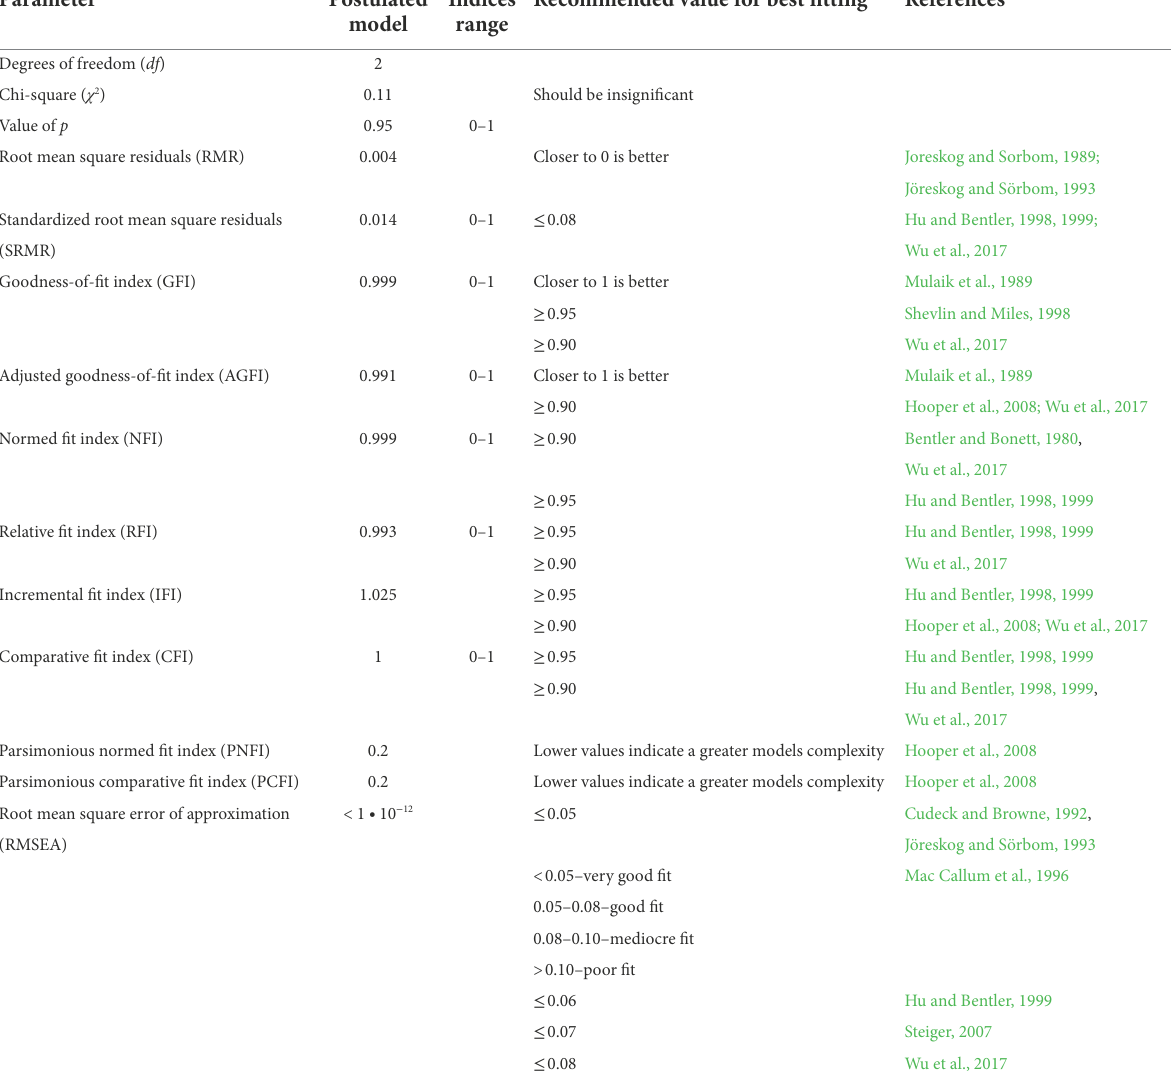
TABLE 4 Summary of the analyzed structural equation model. Parameter Postulated